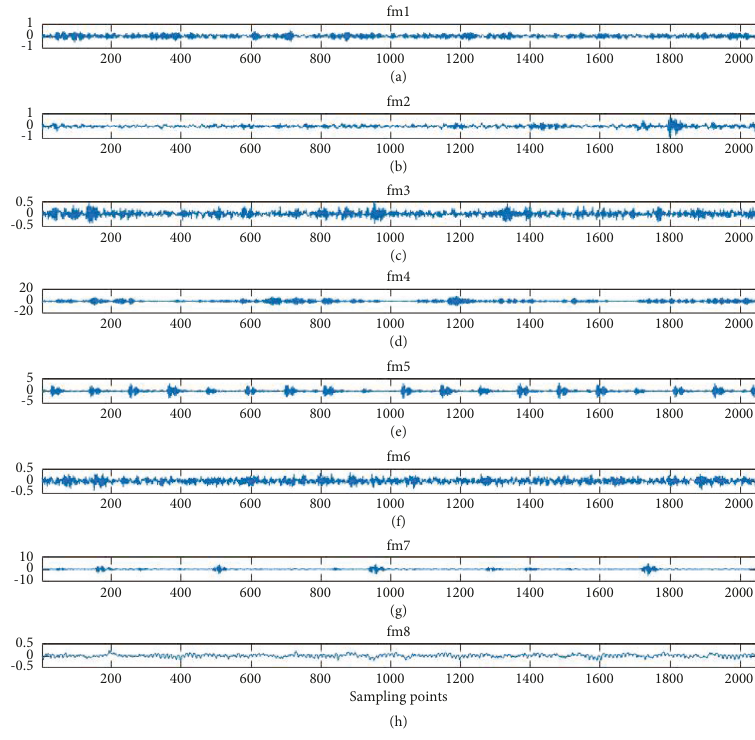
Figure 8: Bearing waveforms on